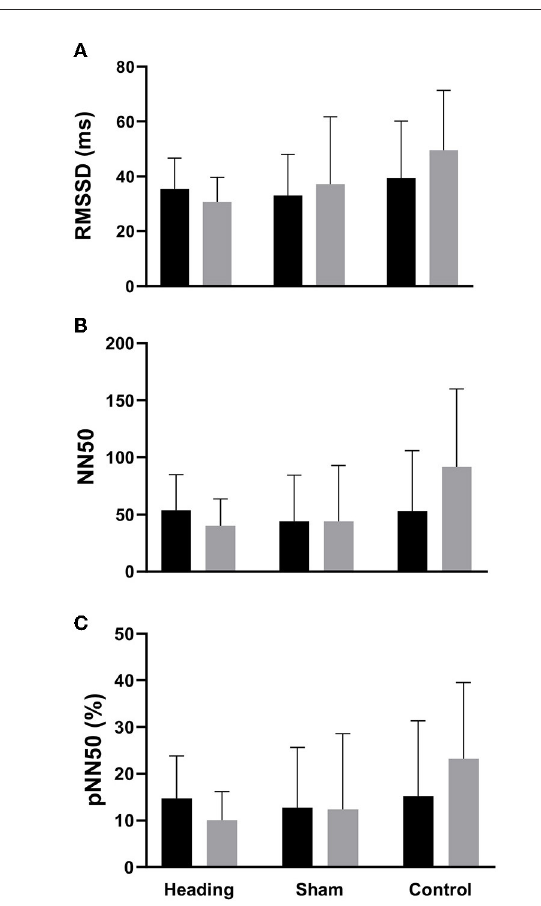
FIGURE3 Time-domain HRV metrics before and after exposure to heading, sham, and control conditions across all participants. (A) Root-mean square differences of successive R-R intervals (RMSSD), (B) Number of adjacent R-R intervals that differ from each other by more than 50ms (NN50), and (C) Percentage of successive R-R intervals that differ by more than 50ms (pNN50). The columns are average values for the group with the standard deviation being represented with the error bars ( p- values all > 0.05).